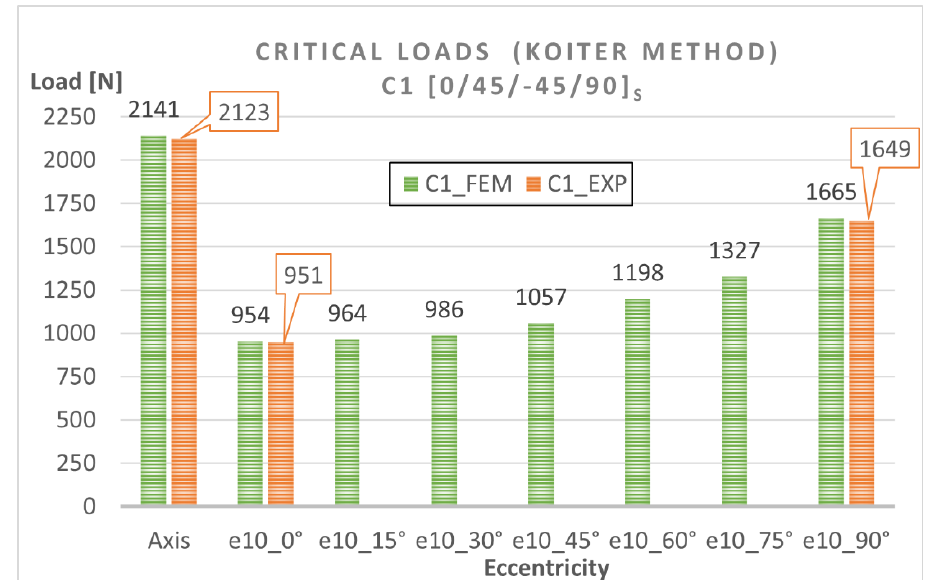
Figure 14. Eccentricity versus critical load for C1 [0/45/ − 45/90] s .